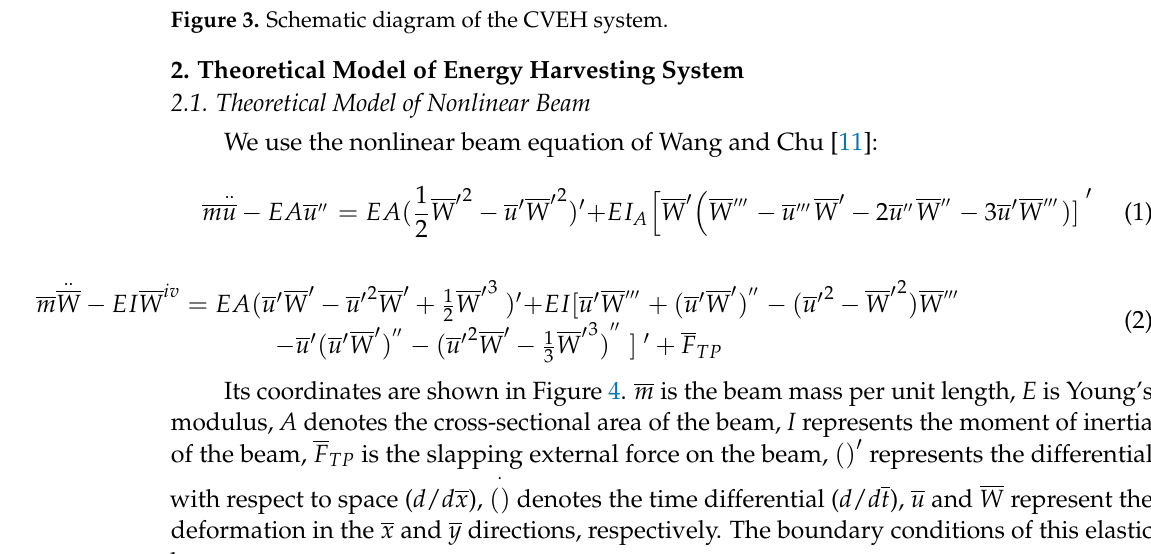
Figure 3. Schematic diagram of the CVEH system.